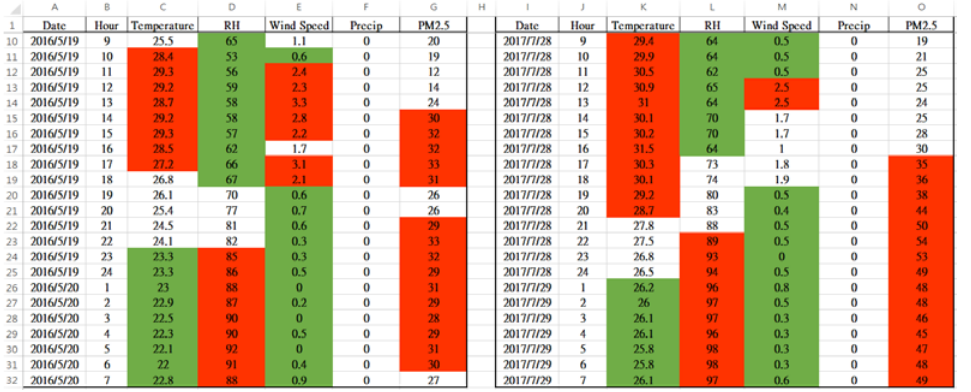
Figure 4. The data labeling for two plausible examples of temperature inversion phenomena.